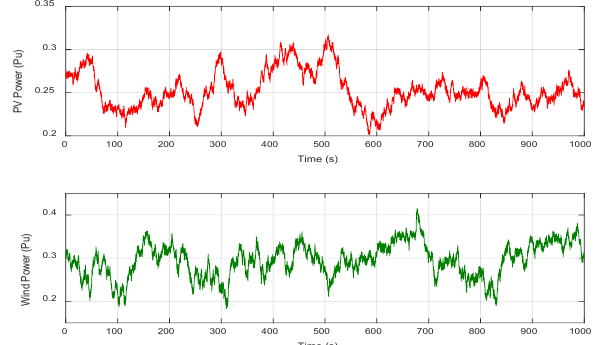
Figure 6. Solar and wind power generation.